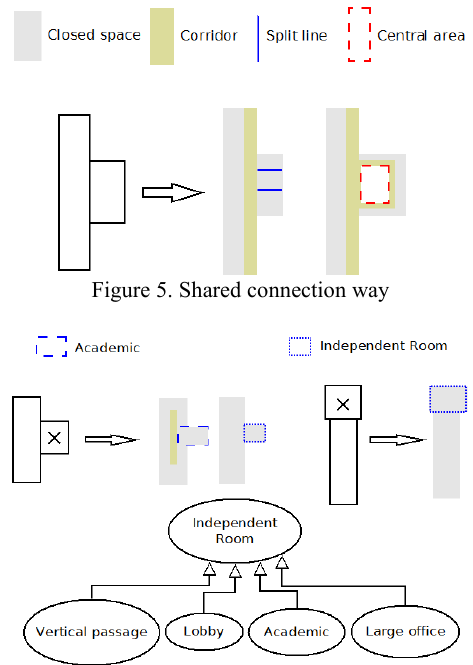
Figure 6. Layout manners of combination rules 5 and